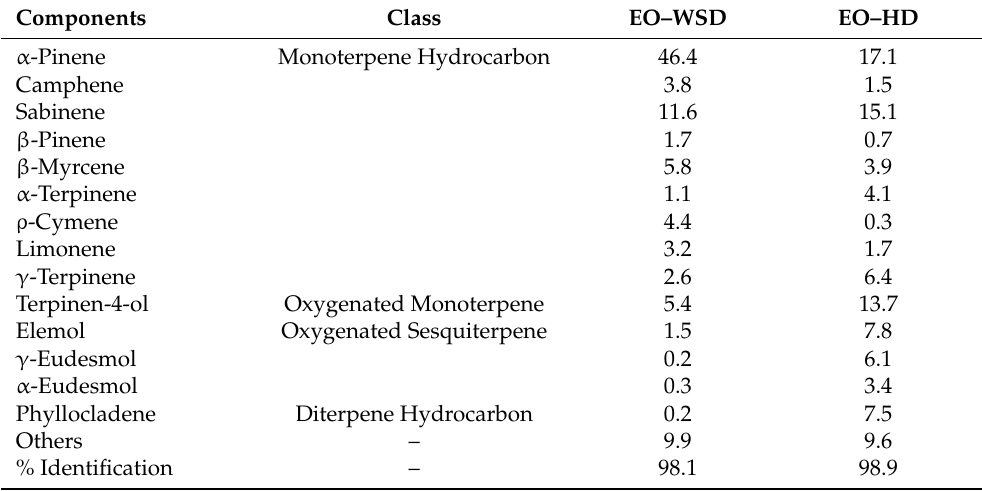
Table 4. Chemical composition (%) of Azorean Cryptomeria japonica leaf essential oils (EOs) obtained by hydrodistillation (HD) and by water-steam distillation (WSD) (adapted from Arruda et al. [13]).